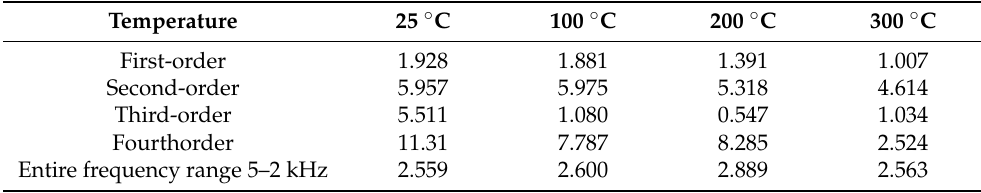
Table 4. Insertion loss ( IL ) of pipeline with LCDS at different ambient temperatures (unit: dB).